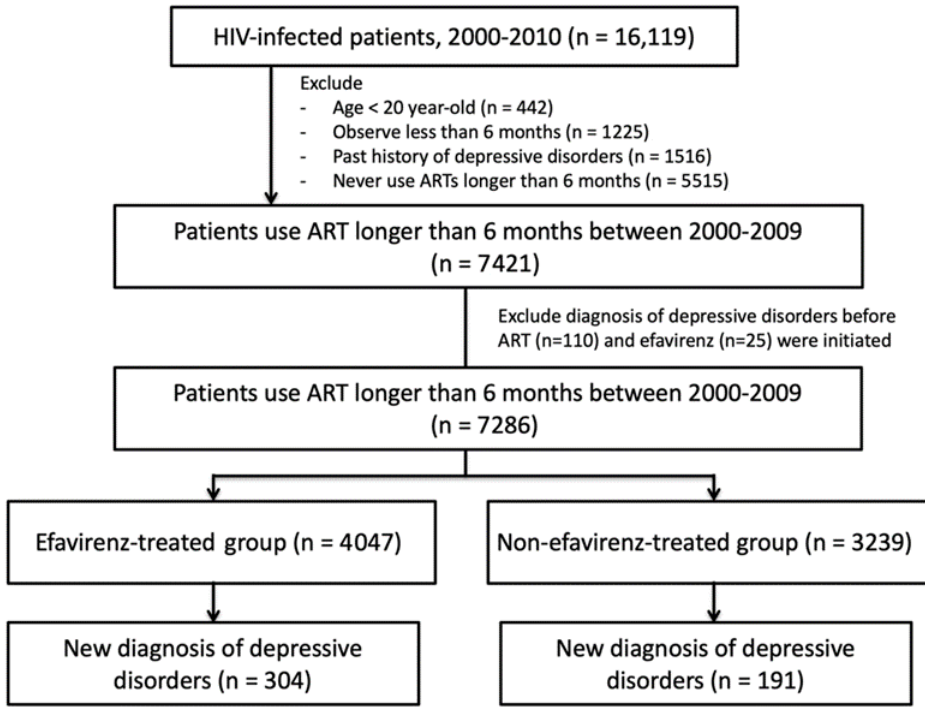
Figure 1. Flowchart of study patients’ enrollment and follow-up.